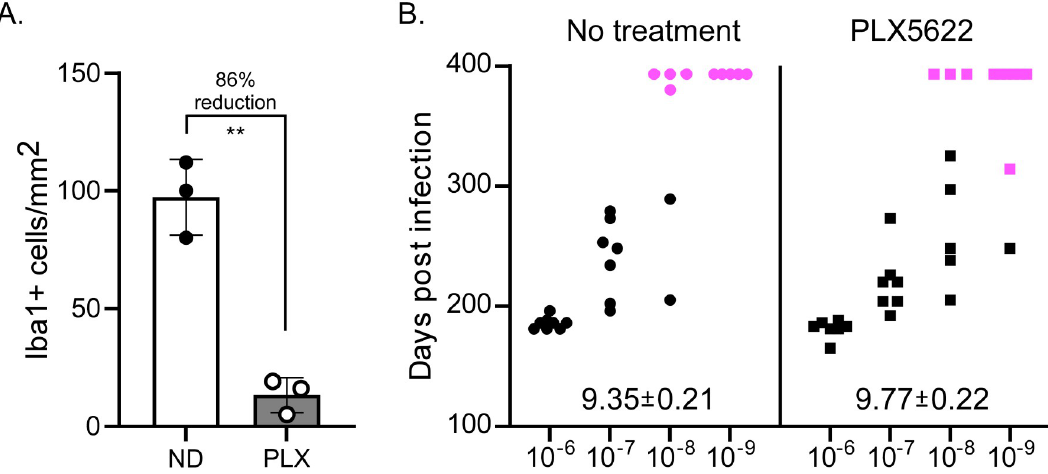
Fig 1. End-point titration of 22L scrapie in untreated and PLX5622 treated mice. PLX5622 was provided continuously from 25 days prior to infection until 60 days after 22L infection. At day 0, serial ten-fold dilutions of 22L scrapie were injected into untreated or PLX5622 treated (MG reduced) mice (N = 5–8 mice /group). Mice were euthanized when they developed clinical signs of scrapie, or at 400 days post-infection. Brains from mice were screened for PrPres by immunoblot to confirm infection. In panel A we assessed the effectiveness of PLX5622 treatment on selected mice from this experimental cohort. Sections of cortex were stained for Iba1, and positive cells were counted manually. Solid circles indicate the number of Iba1+ cells in individual mice with no drug (ND) and the white column is the mean. Open circles indicate the number of Iba1+ cells in individual mice treated with PLX5622 (PLX) and the grey column indicates the mean. The bars in each column represent the standard deviation. In panel B we show the end-point titration of 22L scrapie in untreated and PLX5622 treated mice. �� indicates a P value � 0.01. Black symbols indicate scrapie positive mice, pink symbols indicate scrapie negative. Each symbol represents one mouse. The log LD50 for each group is shown just above the x-axis for each group and was determined using the Spearman-Karber